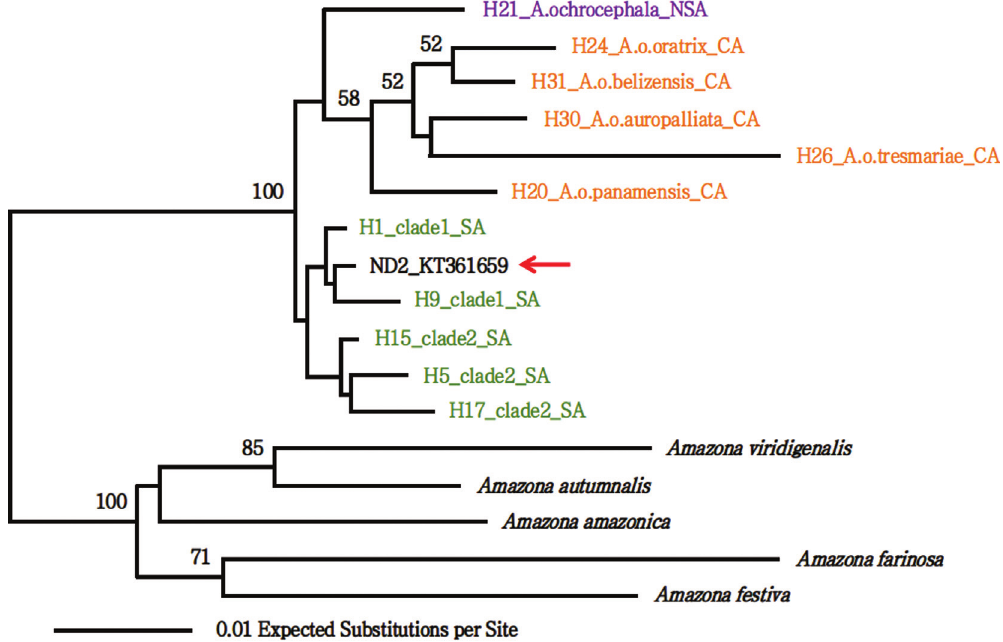
Figure 5 - Tree of the DNA Surveillance for species identification of Brazilian parrots. The ID in bold and marked with a red arrow corresponds to the in- dividual analyzed here (FVVF132). Note that the closest related haplotype is